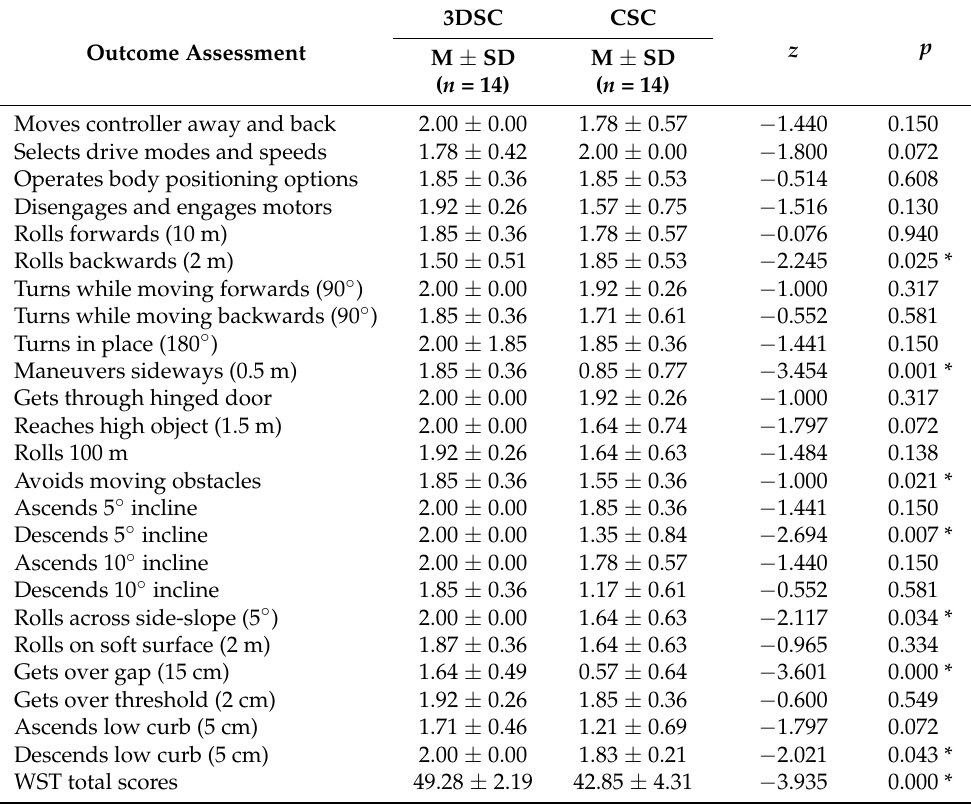
Table 3. Comparison of WST Performances (Version 4.2) in each system-Male ( n =